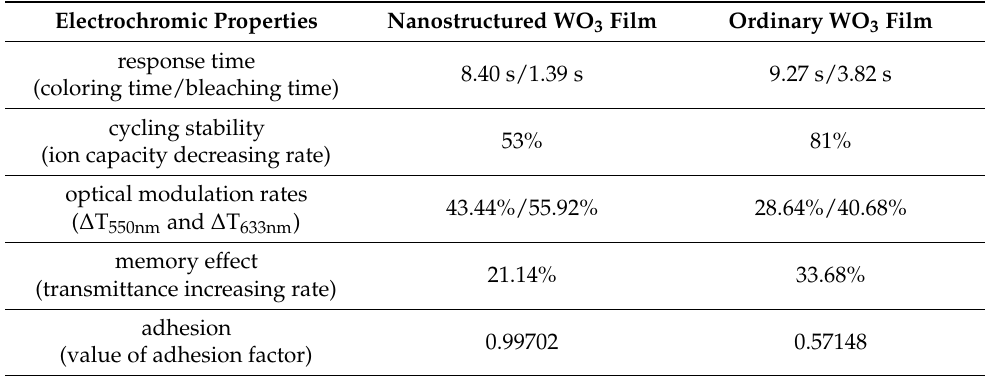
Table 1. Comparison between the nanostructured WO 3 film and the ordinary WO 3 film. Electrochromic Properties